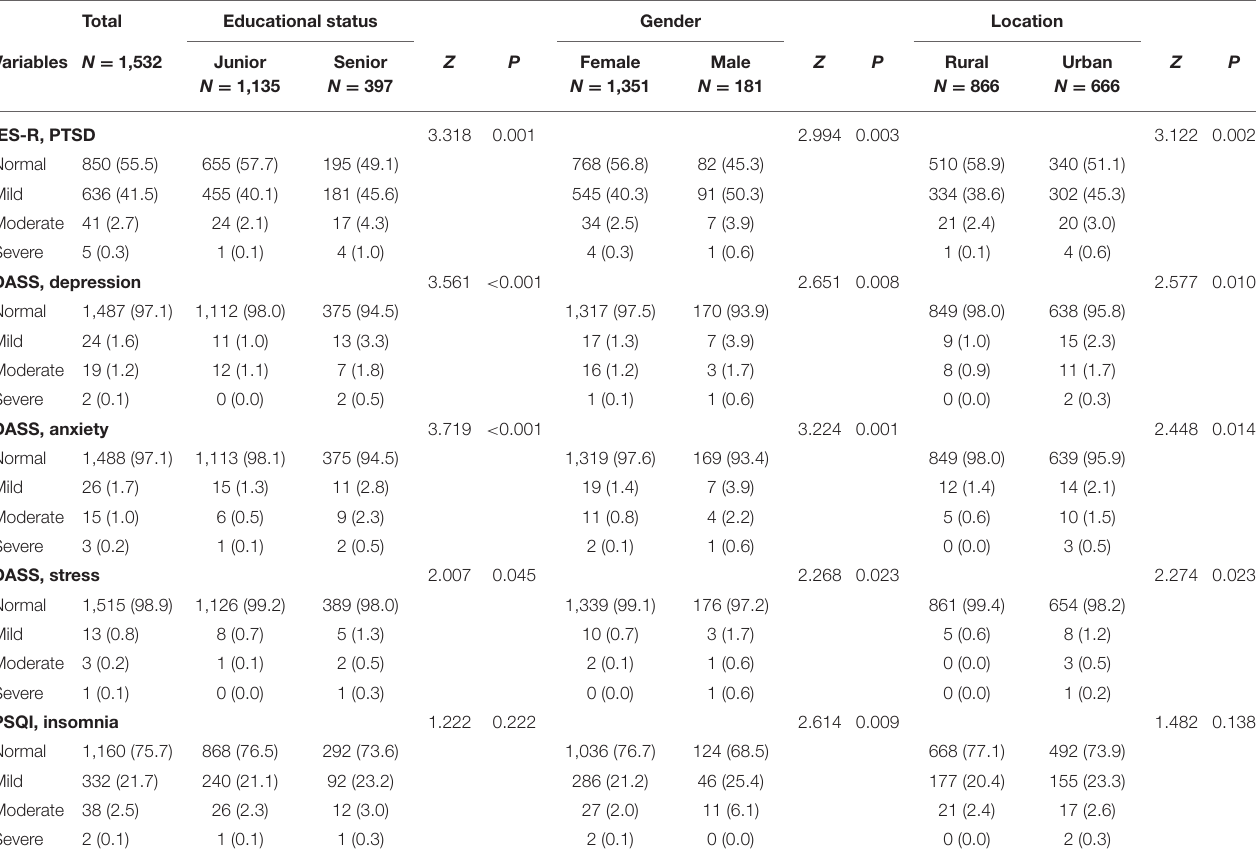
TABLE 3 | Severity Classifications of PTSD, depression, anxiety, stress, and insomnia